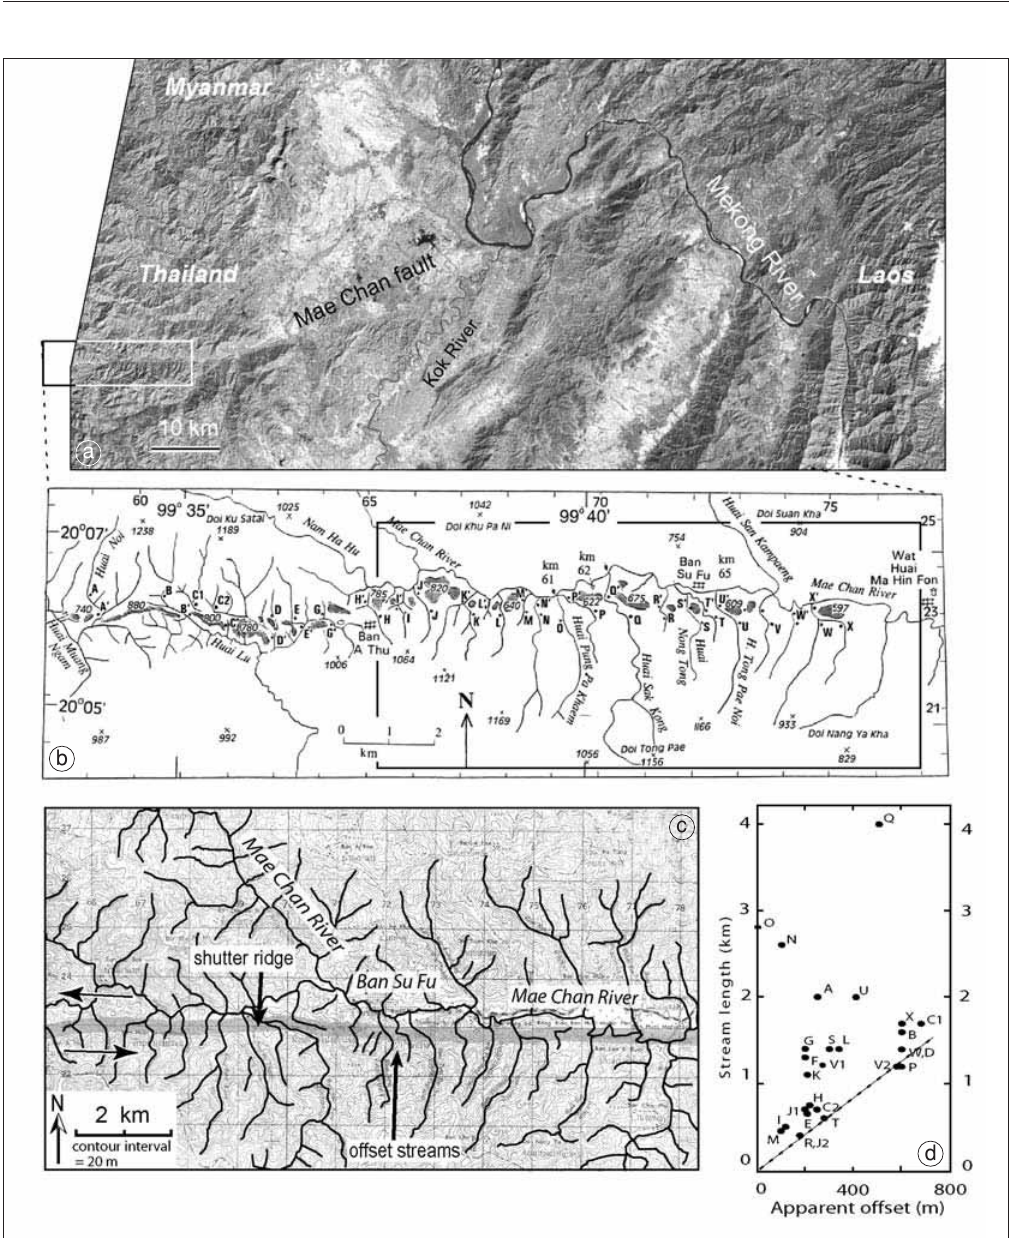
Fig. 13a-d. a) Landsat image of the Mae Chan Fault and Mekong River in northernmost Thailand. River flows from top of image to the southwest (image processed and furnished by Michael J. Rymer, U.S. Geological Survey, Menlo Park, California). b) Offset streams, shutter ridges, and water gaps along the Western Mae Chan Fault. c) Detail of stream offsets near Ban Su Fu. d) Graph of offset versus stream length. One group of streams 0.5-to-0.7 km long is offset 100 to 300 m, while another group 1.1-to-1.8 km long is offset about 600